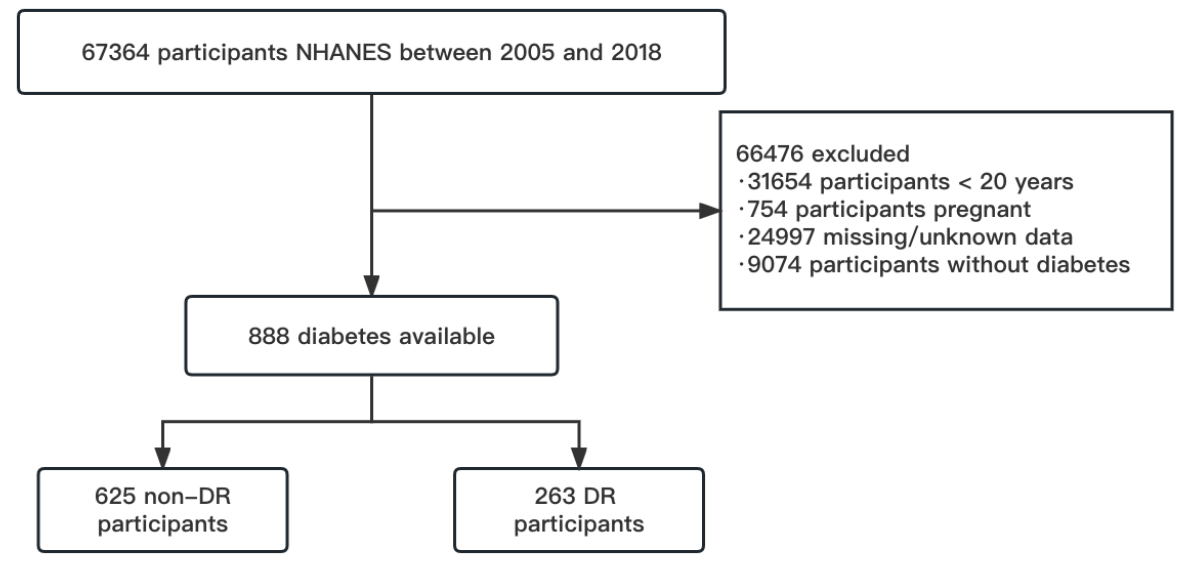
Figure 1. The participant screening flow diagram.